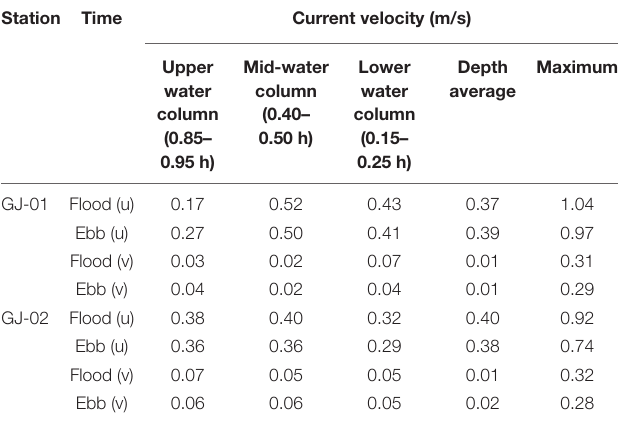
TABLE 2 | Statistics of current velocity at the two stations. Station Time